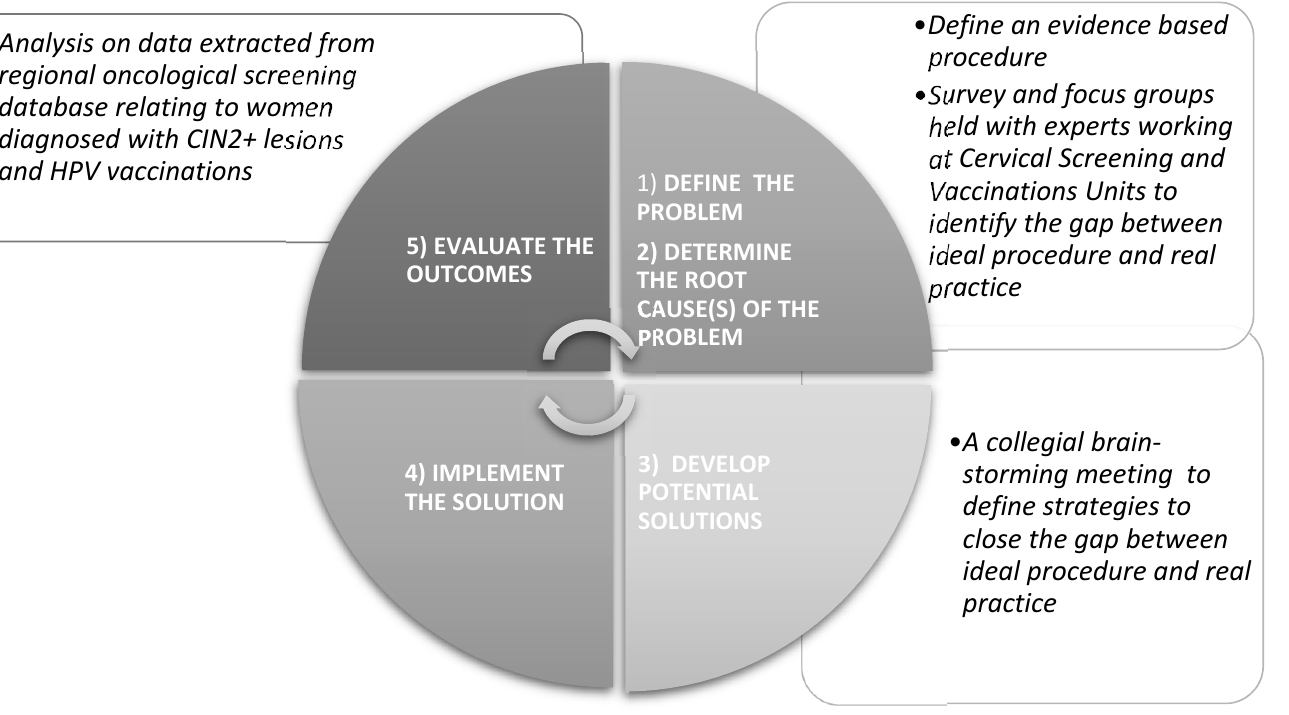
Figure 1. Conceptual framework of the Continuous Quality Improvement (CQI) project carried out by the Veneto Region Prevention Directorate regarding the HPV vaccination in women diagnosed with CIN2+.